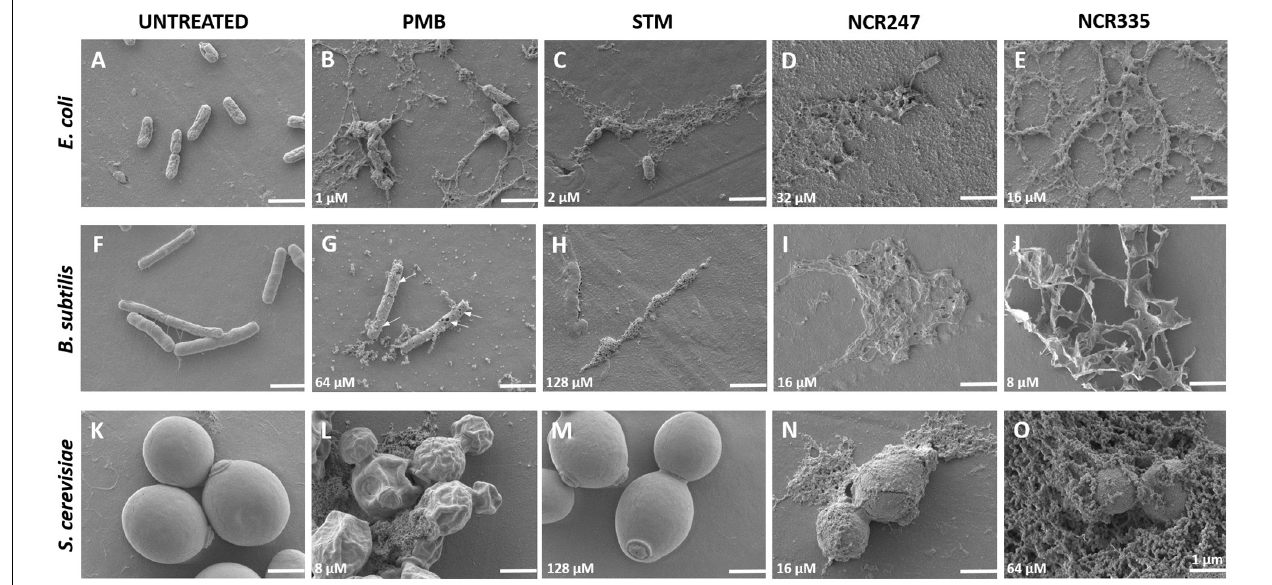
FIGURE 2 | Morphology of control (untreated) and peptide/antibiotics treated E. coli , B. subtilis and S. cerevisiae at MBCs observed with Scanning Electron Microscopy. All treatments were made in LSM at minimal bactericidal concentration (MBC) shown in the lower left corner of each panel. The arrows (panel G ) point to the holes on the Bacillus cells. Scale bar: 1